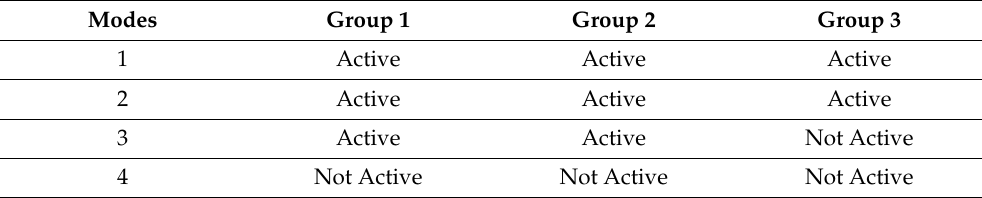
Table 3. Load Energy